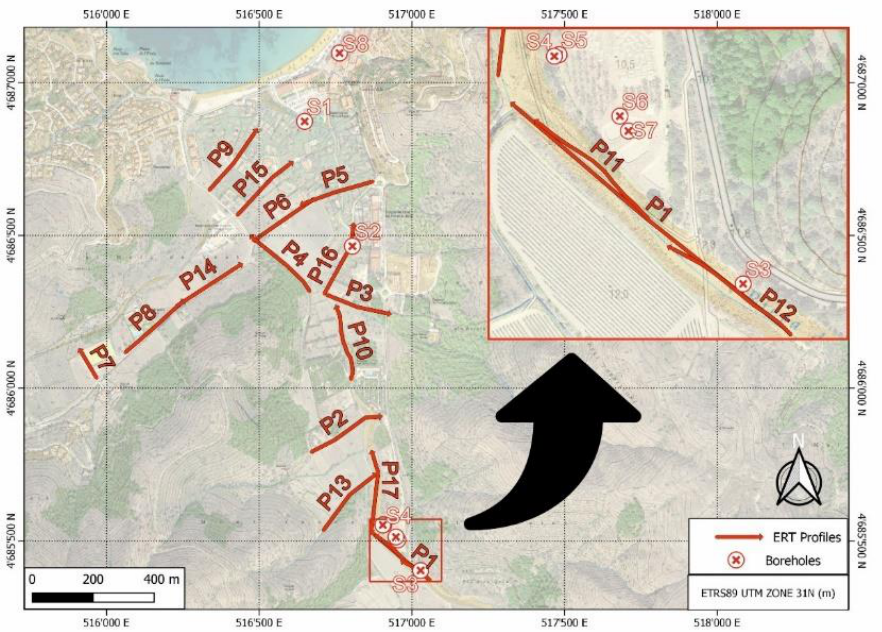
Figure 4. Location of the electrical resistivity tomography profiles and boreholes (Port de la Selva).